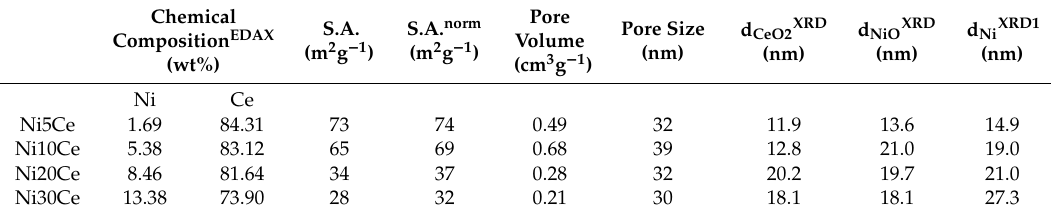
Table 1. Chemical composition, textural properties and crystallite size of catalysts.